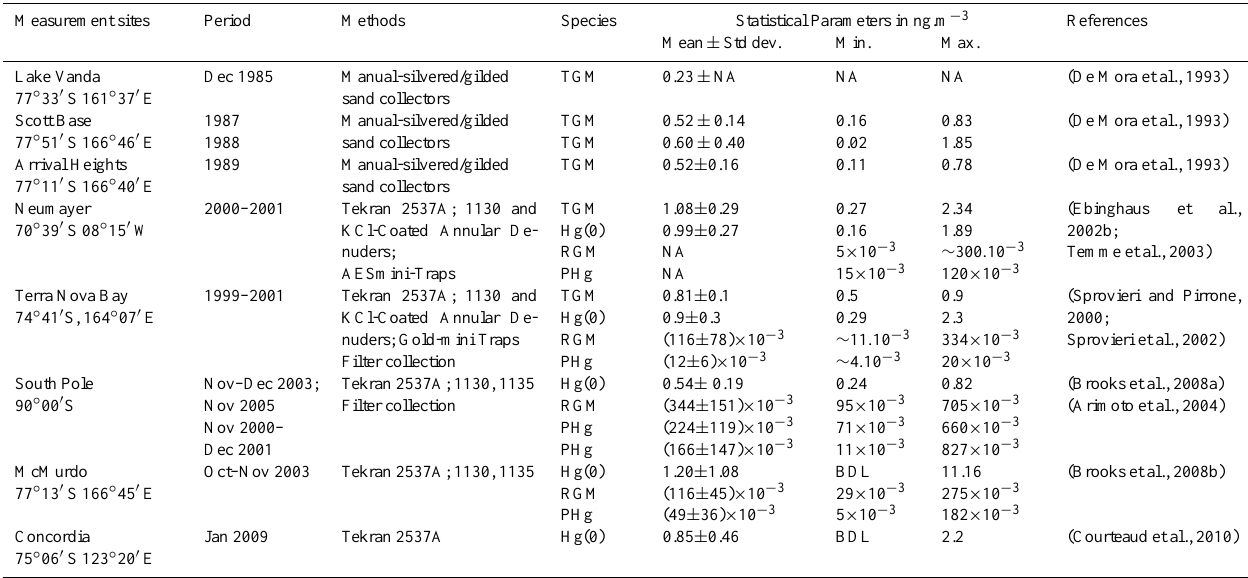
Table 2. Summary of atmospheric mercury measurements performed at different Antarctic locations from 1985 to 2009. NA: data not available; BDL: concentrations below detection